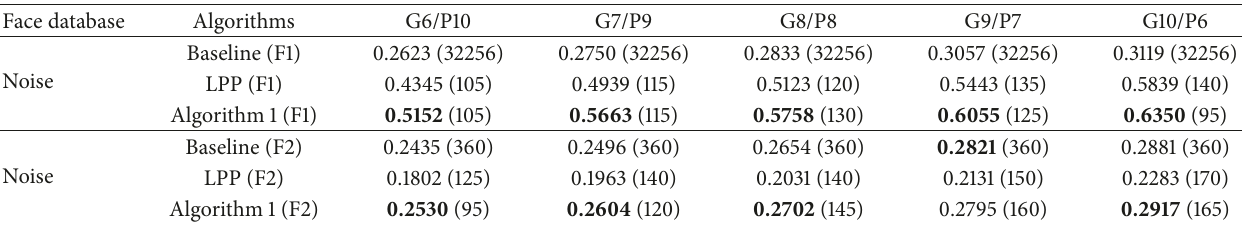
Table 17: The recognition rates on noise Extended Yale B face database over “F1” and “F2” features; recognition rates (dimensionality). Face database